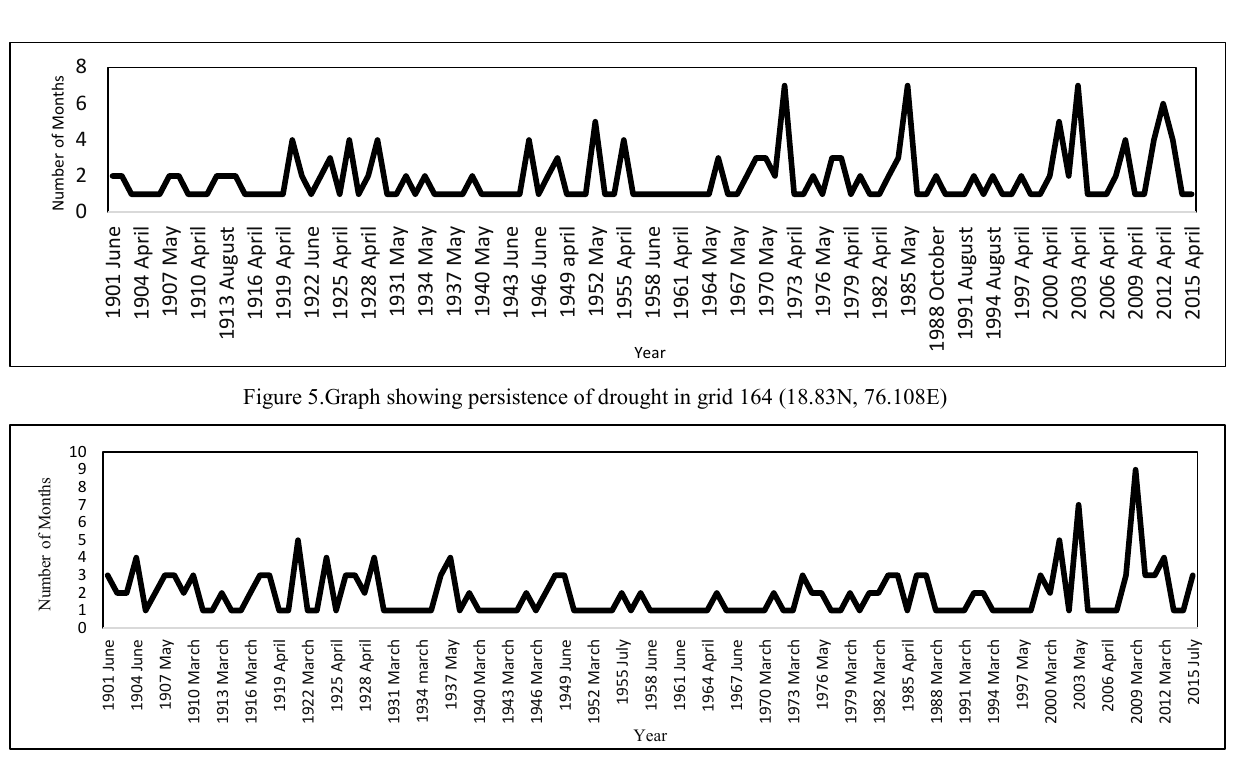
Figure 6.Graph showing persistence of drought in grid 166(18.83N,76.108)